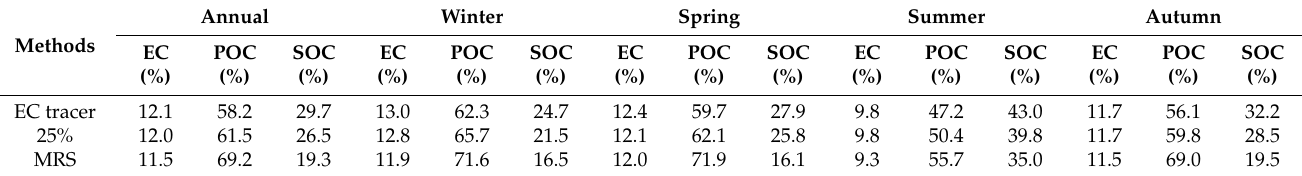
Table 2. Percentage contributions of POC, SOC (estimated via EC tracer, percentile, and MRS methods), and EC to total carbon (TC = OC + EC) mass at Nainital for the entire study period and for four different seasons.